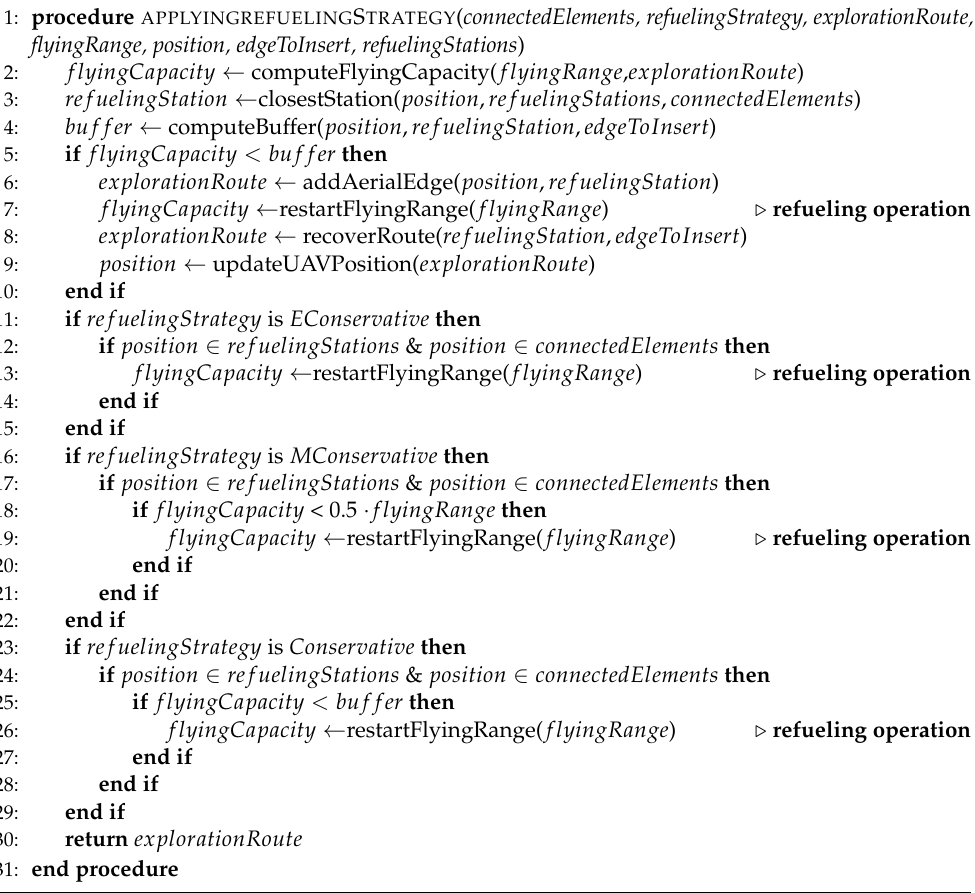
Figure 7. Example of the dynamic buffer. Algorithm 1 Control flying capacity